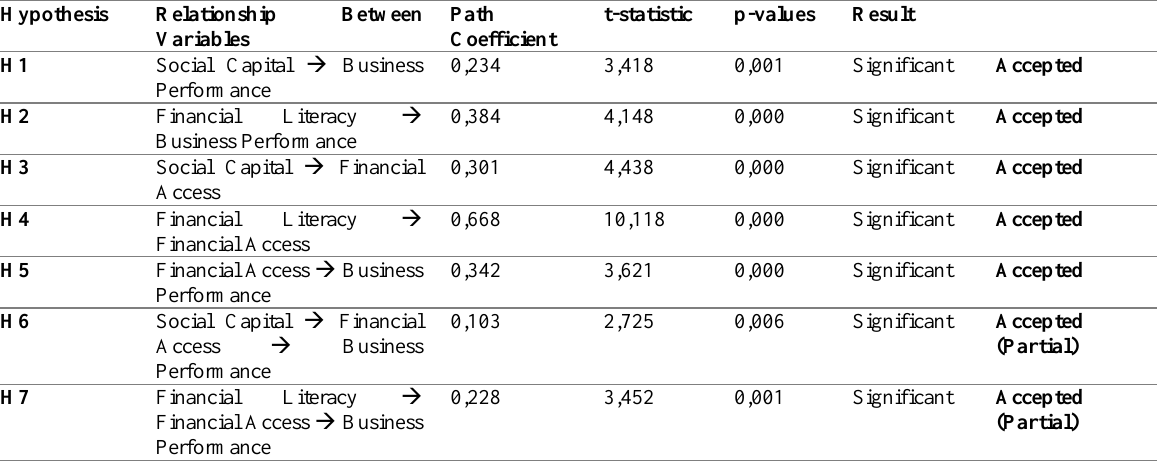
Table 2: Results of Direct Effect Hypothesizes